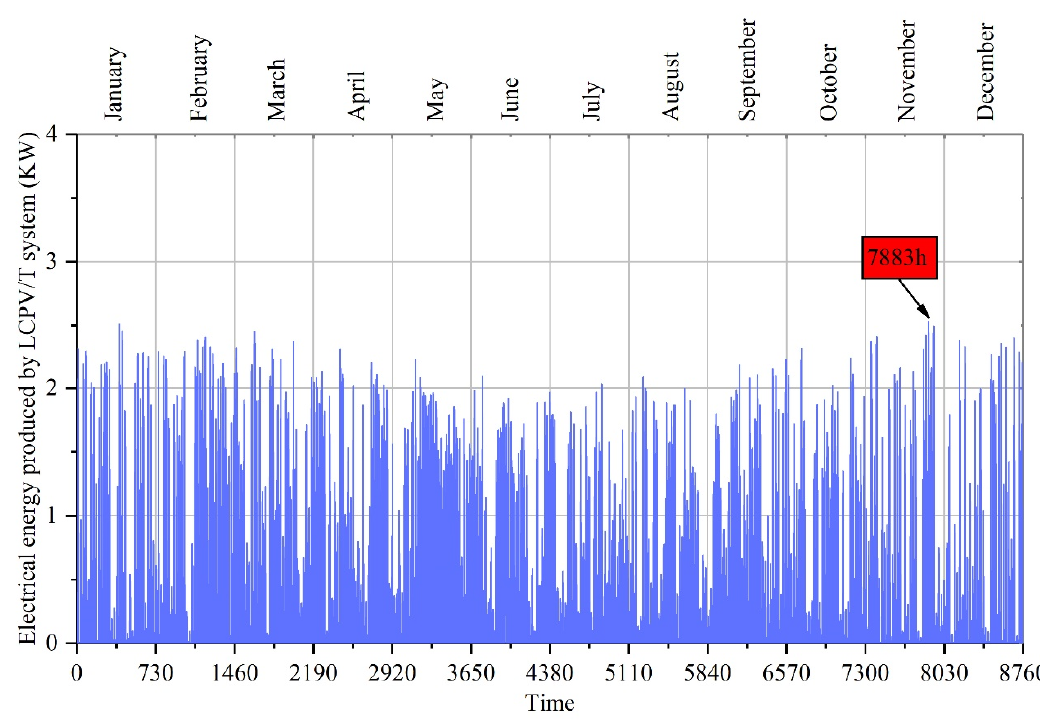
/ T system during a Figure 8. Produced electrical energy of LCPV/T system during a year. Figure 8. Produced electrical energy of LCPV Figure 8. Produced electrical energy of LCPV/T system during a year.